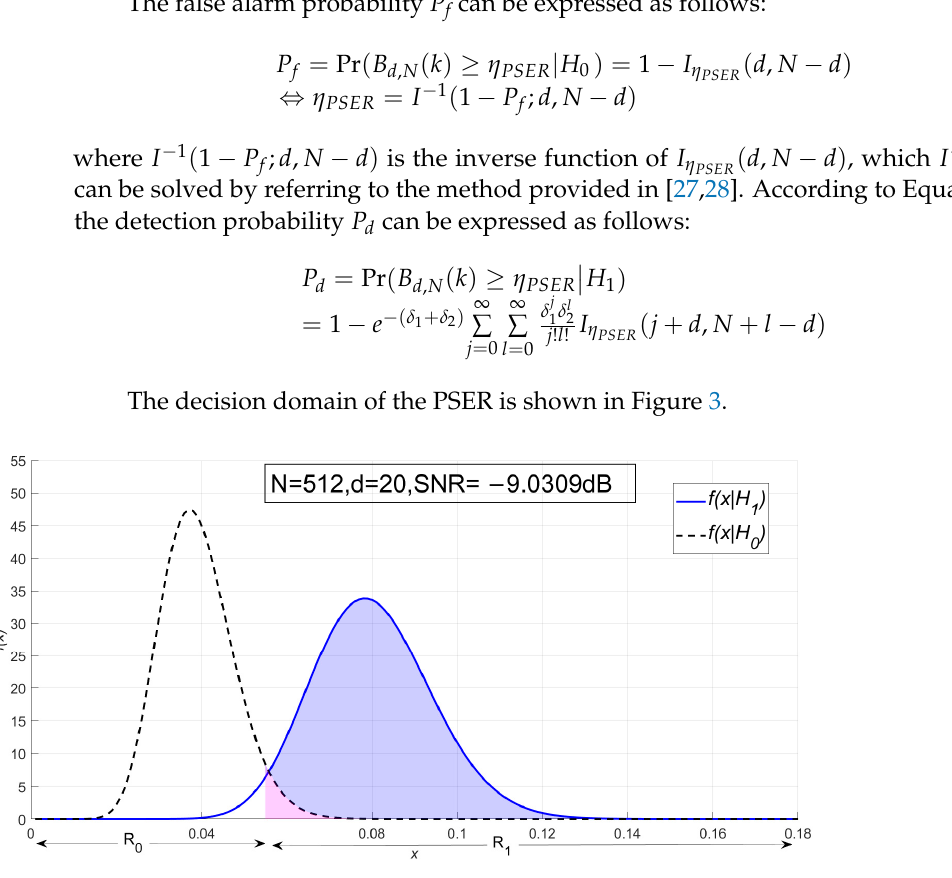
Figure 3. Probability density function of the power-spectrum sub-band energy ratio (PSER) and division of decision domain. In Figure 3, δ 1 = 26, δ 2 = 38, and the SNR is − 9.03 dB. The dotted line is the